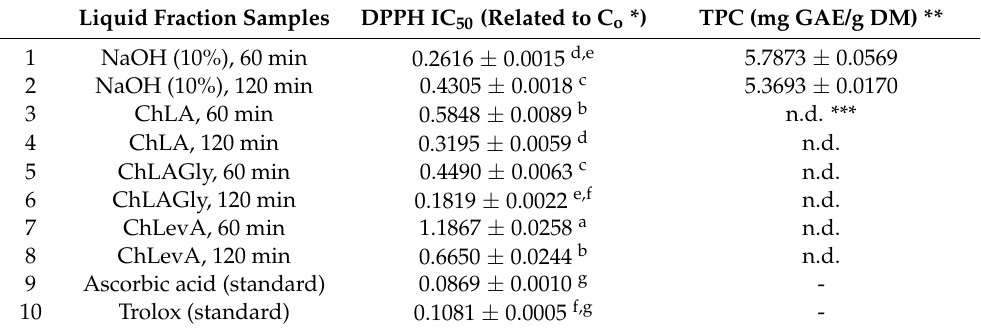
Table 2. Scavenging activity by DPPH assays and TPC for the liquid fractions obtained after grape stalks (GS) delignification processes via UAE (40 kHz, 200 W). Results are expressed as mean ± SD. Values within each variable (for DPPH) with different letters are significantly different ( p < 0.05). Liquid Fraction Samples DPPH IC 50 (Related to C o *) TPC (mg GAE/g DM)